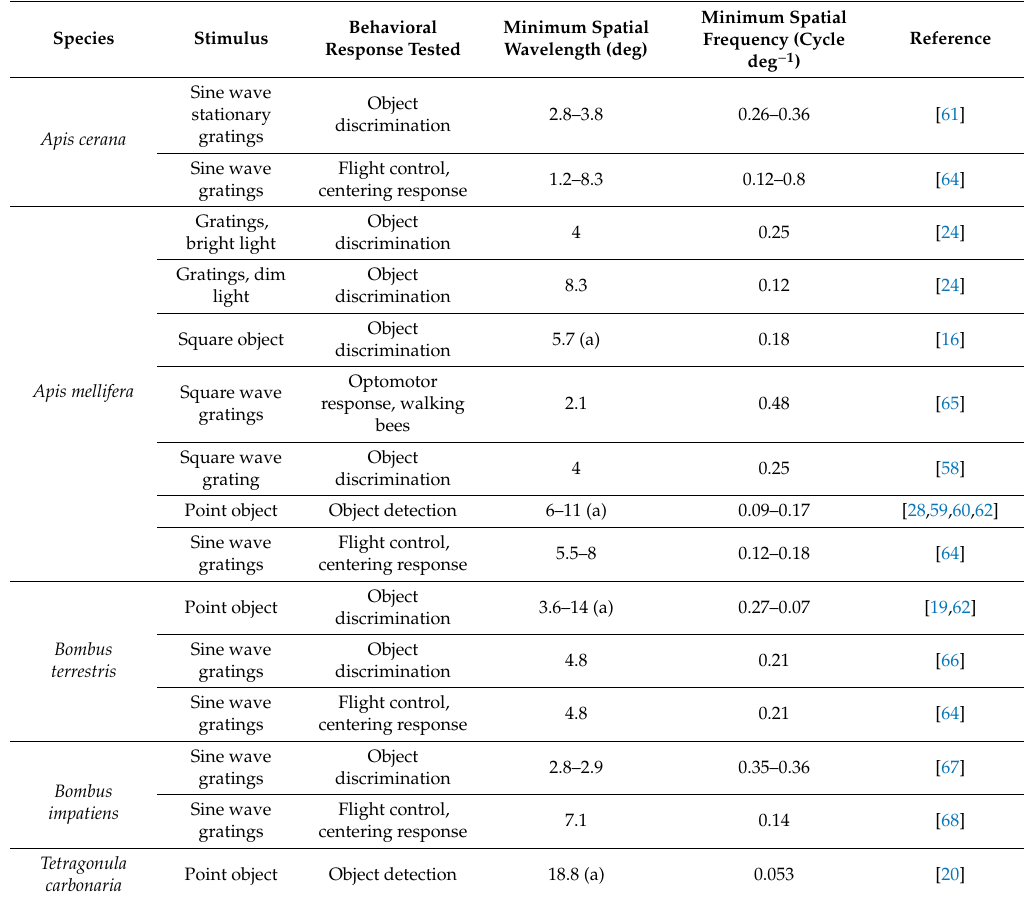
Table 3. Behaviorally determined thresholds of spatial resolution in bees. (a) values for point objects are calculated taking the visual angle obtained by the object as half the resolvable wavelength, allowing for direct comparison with the other data sets. Thus, bees can detect objects subtending half the diameter indicated